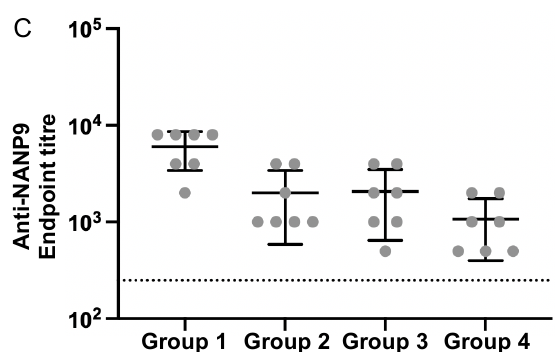
Figure 4. Assessment of immunogenicity of wt and mutant NANP9-VLP platforms in BALB/c mice with a pre-existing anti-HBsAgS antibody response (Groups 1 and 2), or in the absence of a pre-existing anti-HBsAgS (Groups 3 and 4). Test Groups 1 and 3 immunized with NANP9-M1 VLPs with wt HBsAgS backbone, Groups 2 and 4 with NANP9-M15 VLPs with mutant HBsAgS backbone (Supplementary Table S2). ( A ) ELISA to determine anti-HBsAgS antibody titers in Groups 1 and 2 mice before immunization with NANP9-containing VLPs, n = 7, in duplicate, graphed mean ± SD. ( B , C ) Determination of anti-HBsAgS ( B ) and anti-NANP9 ( C ) antibody endpoint titers. Sera were collected 13 days after the final immunization with chimeric NANP9-containing VLPs and tested for reactivity with ( B ) wt HBsAg VLPs and ( C ) NANP9 peptides, in duplicate, graphed mean ± SD. Titration of individual mouse sera in Supplementary Figure